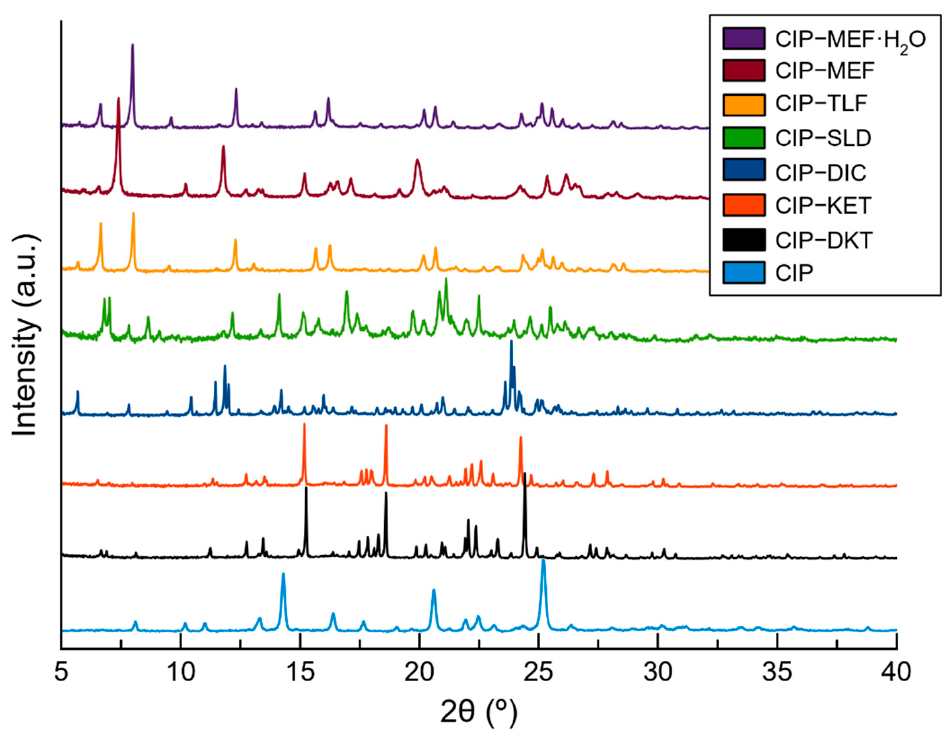
Figure 1. Powder X-ray diffraction (PXRD) patterns for CIP and the new solid forms reported in this work.